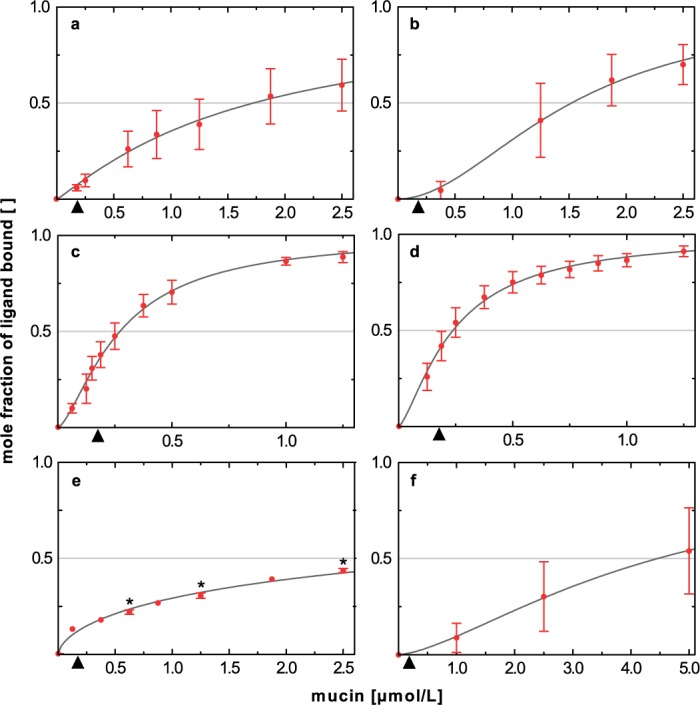
Fitted binding isotherms of polyphenols titrated with increasing levels of salivary mucin.The mole fraction of polyphenol bound to mucin is plotted against the protein concentration. The concentration of EC (a), EGC (b), ECG (c), EGCG (d), methyl gallate (e), and rutin (f) was kept constant (2.5 mmol/L), whereas salivary mucin was titrated from 0 to 2.5 μmol/L or until the bound mole fraction of the ligand reached a plateau. The approximate mucin content of human whole saliva is marked by an arrow. The intercept of the fitted binding isotherm with the horizontal gray line marks the half-maximum binding concentration of the protein (BC50). Error bars denote the standard deviation obtained from integrating all the distinct, non-overlaid proton signals of each compound (see methods for a list of consulted proton resonance signals). For methyl gallate only one discrete 1H resonance signal is available for integration. *Error bars in (e) denote the technical error of two independent measurements. Data points behind means are provided in S1 Table. Binding isotherms, the BC50 value, and the shape parameter α were fitted with the Gnuplot software (Version 5.0).